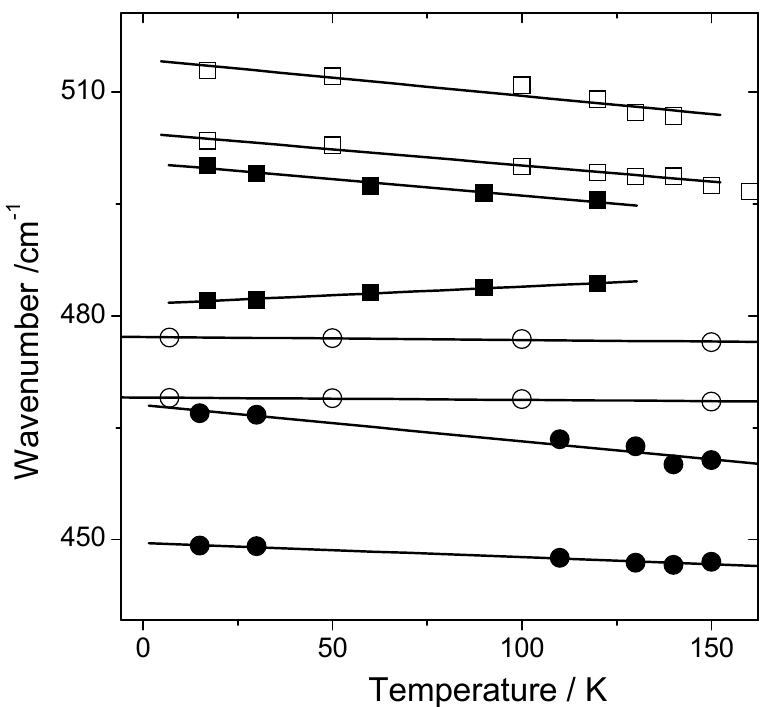
Figure 2. Linear fitting for wavenumber thermal evolution of the of Raman bands associated with NH 3 + torsional vibration. L-valine ( (cid:3) ), L-isoleucine ( (cid:4) ), taurine ( ◦ ) and L-arginine hydrochloride monohydrate ( (cid:8) ) crystals.